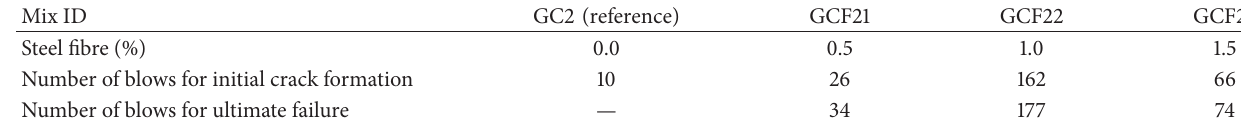
Table 7: Total number of blows for various percentage of steel fibre in concrete.